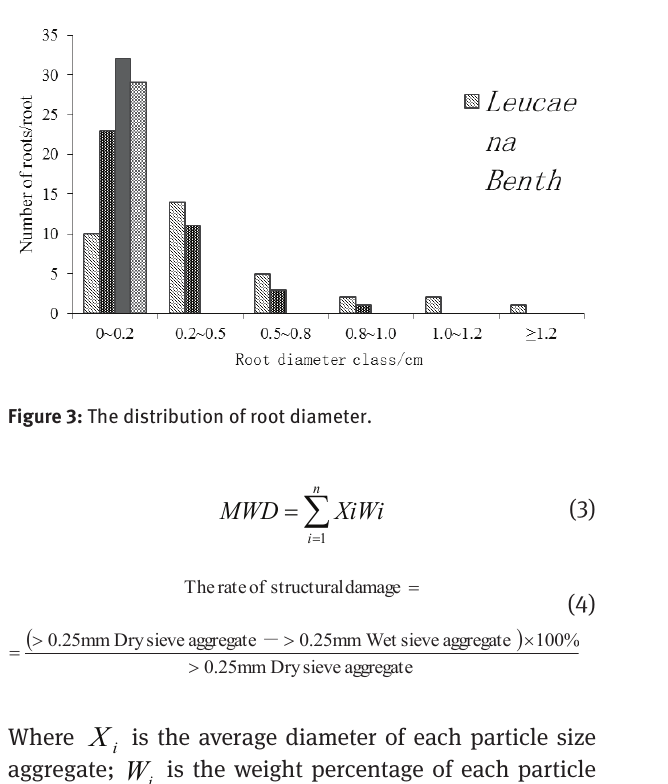
Table 2: Basic properties of the tested soil.